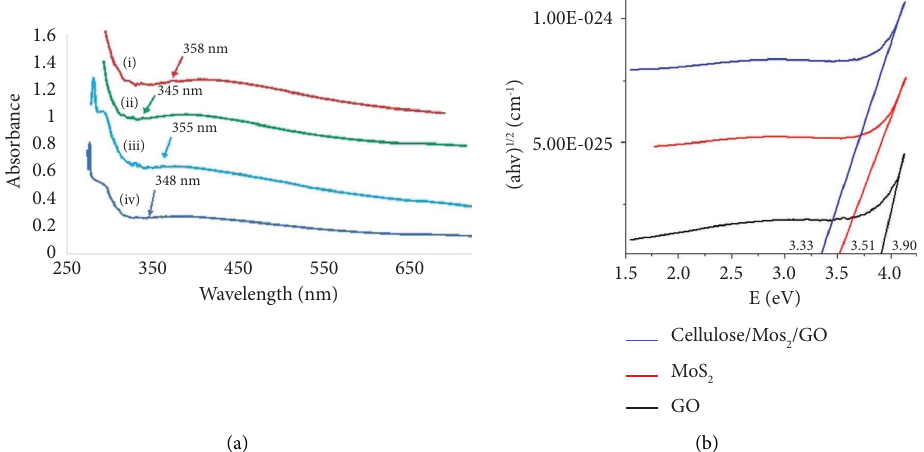
Figure 2: (a) UV-visible spectra: (i) cellulose nanofber, (ii) MoS (b) band gap energy.